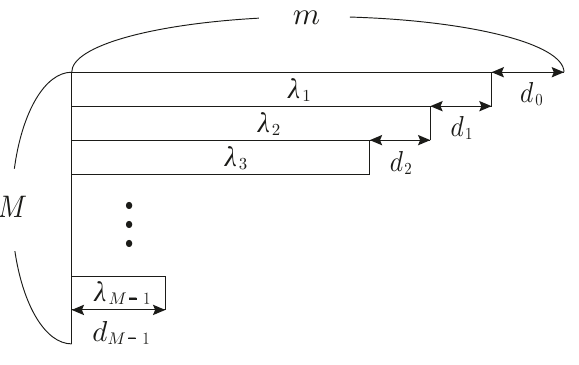
Figure 1 . The partition par((cid:3)) for a dominant weight (cid:3) = [ d 0 ; d 1 ; : : : ; d M (cid:0) 1 ] 2 P +